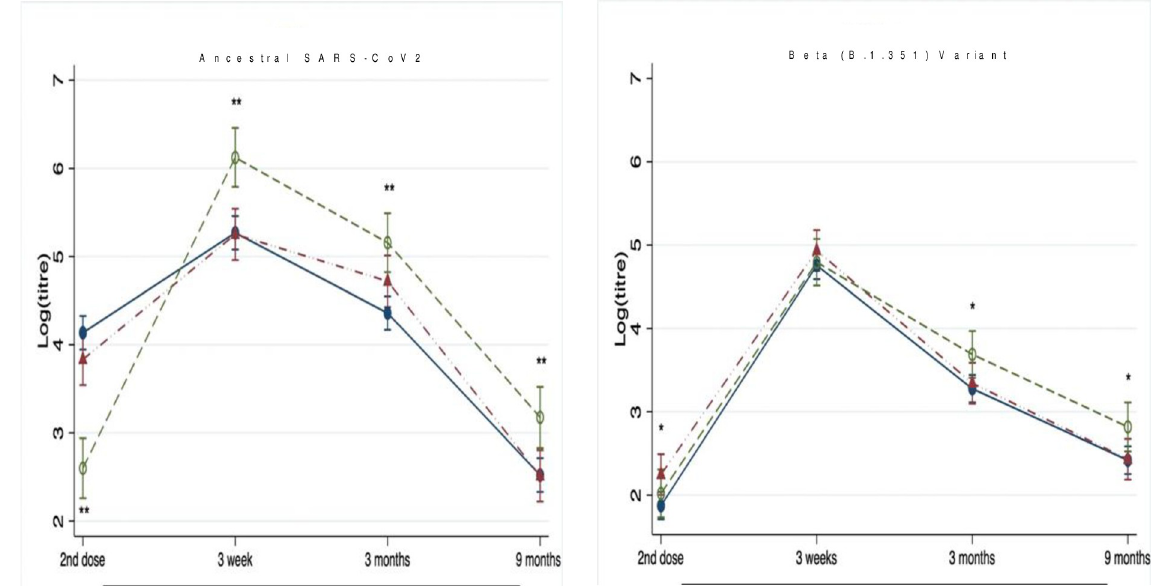
Fig 5. Neutralizing titers to live ancestral SARS-CoV-2 and Beta variant by visits stratified by dosing interval groups. Data are presented as logarithmic titers (means and 95% CI) needed to inhibit 50% of infection due to Ancestral or Beta variants after fully adjusted for age, sex, education, smoking, alcohol use, body-mass index, known comorbidities (cardiovascular, neoplastic, autoimmune, renal and chronic respiratory diseases) and the number of days after 2 nd vaccine dose to subsequent blood draw. The dosing interval groups were 35-42-days (red symbols) and > 42-days (open green symbols), who were compared to the < 35-days group (reference group, blue closed symbols). For the summary numerical data, please refer to S4 Appendix in S1 File. Interaction terms for titer levels x visit x group was significant at p < 0.0001. Therefore, between group comparisons ( < 35-day group as reference) were conducted with p-values � < 0.05 and �� <